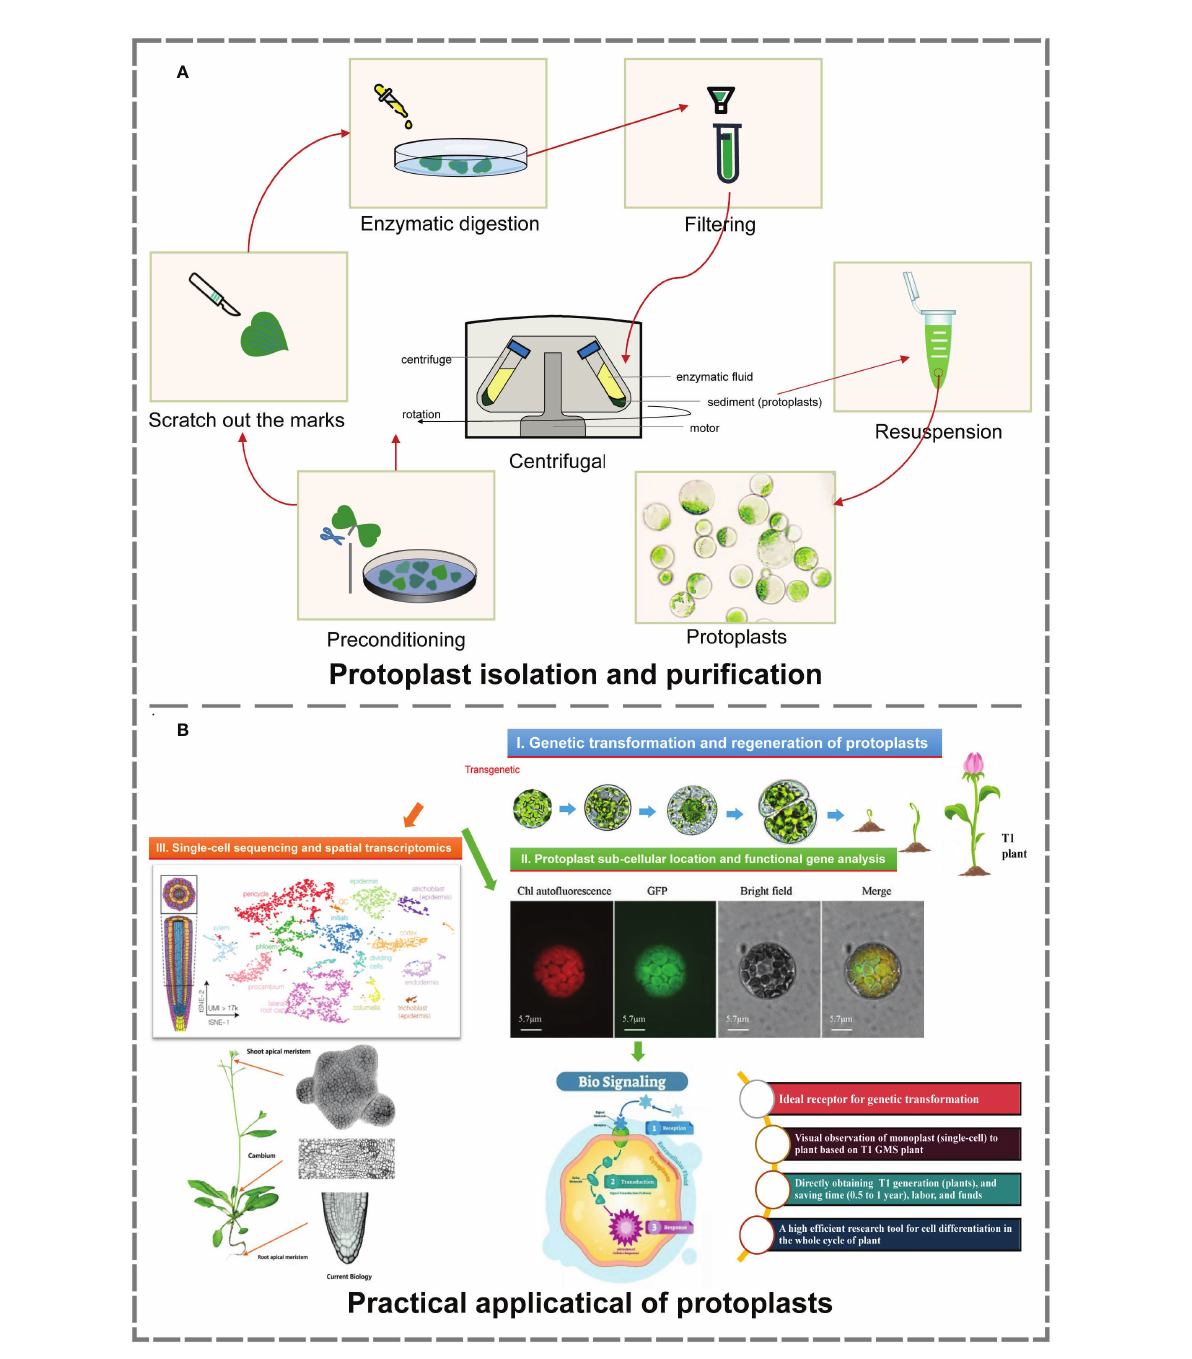
FIGURE 4 Isolation, puri fi cation and practical application of protoplasts (Buckley, 2015; Greb and Lohmann, 2016; Tanveer and Yousaf, 2020; Moses and Pachter, 2022). (A) The process of protoplast isolation and puri fi cation. The material and production of images based on our research. (B) Main practical applications of protoplasts. Image material from references, typesetting and production based on our